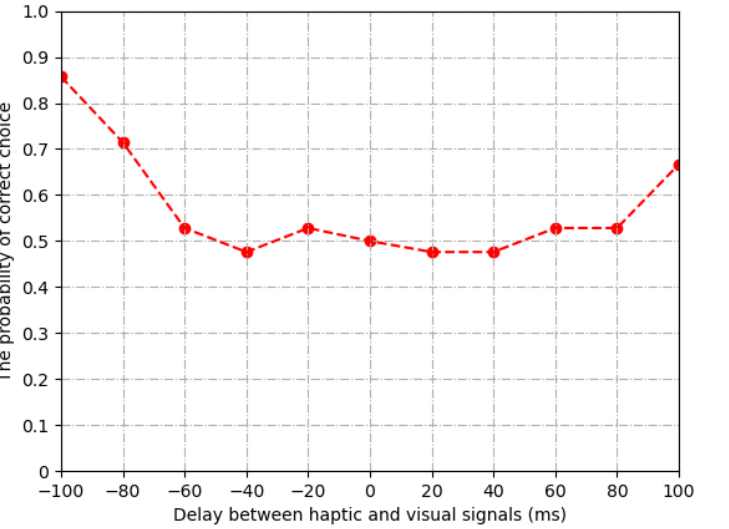
Figure 6. Subjective result of synchronization